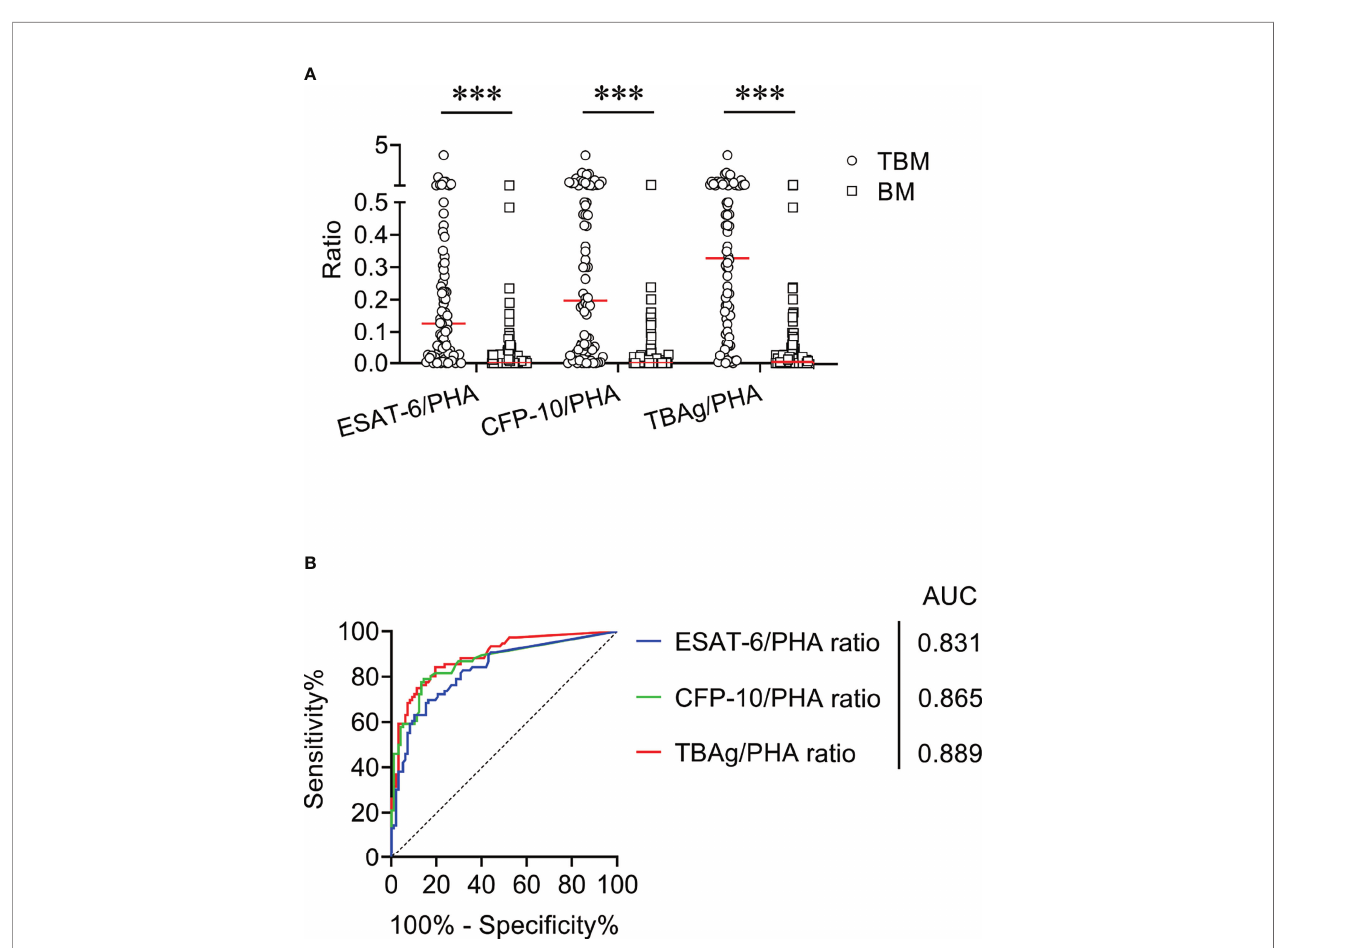
FIGURE 2 | The performance of TBAg/PHA ratio for distinguishing TBM from BM in Qiaokou cohort. (A) Scatter plots showing the levels of ESAT-6/PHA ratio, CFP- 10/PHA ratio, and TBAg/PHA ratio in TBM patients (n = 76) and BM patients (n = 98). Horizontal lines indicate the medians. *** P < 0.001 (Mann – Whitney U test). (B) ROC curve analysis showing the performance of ESAT-6/PHA ratio, CFP-10/PHA ratio, and TBAg/PHA ratio in distinguishing TBM from BM. TBM, tuberculous meningitis; BM, bacterial meningitis; ESAT-6, early secreted antigenic target 6; CFP-10, culture fi ltrate protein 10; PHA, phytohemagglutinin; TBAg, tuberculosis- speci fi c antigen; ROC, receiver operating characteristic; AUC, area under the ROC curve.